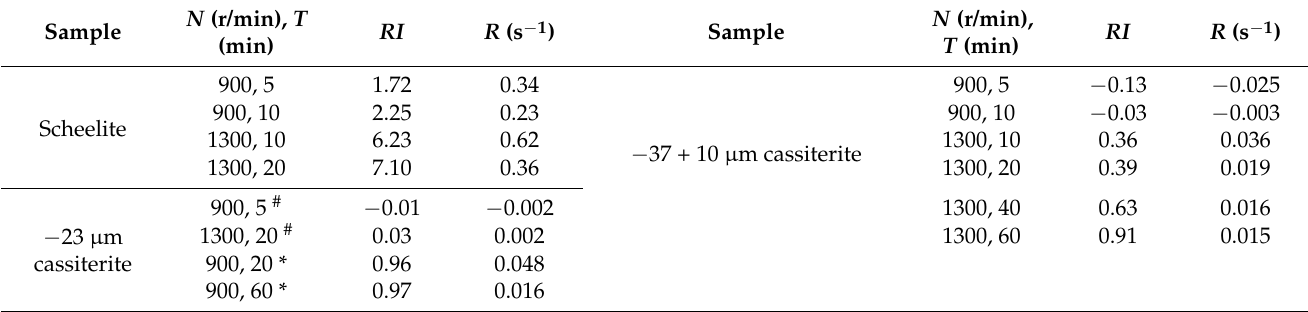
Table 3. Relative increment of aggregate particle size ( RI ) and relative growth rate of aggregates ( R ) of the mineral stirred suspensions in the presence of NaOL at different stirrer speeds ( N ) and stirring times ( T